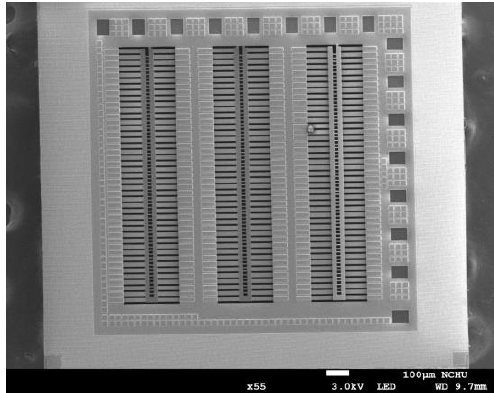
Figure 8. Fabrication of the microgenerator, ( a ) completion of CMOS process; ( b ) etching silicon oxide; ( c ) removing substrate; ( d ) coating CNCs film.